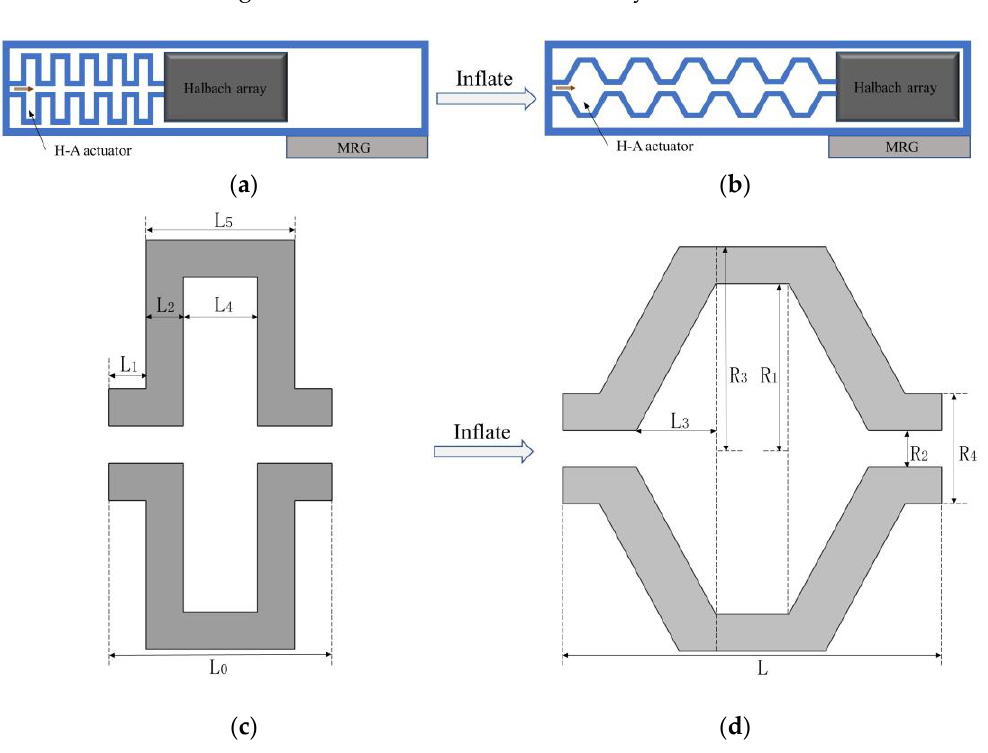
Figure 3. Schematic of the H − A actuator motion process and simplified diagram of an air chamber in an H − A actuator. ( a , c ) The state before inflation; ( b , d ) The state after